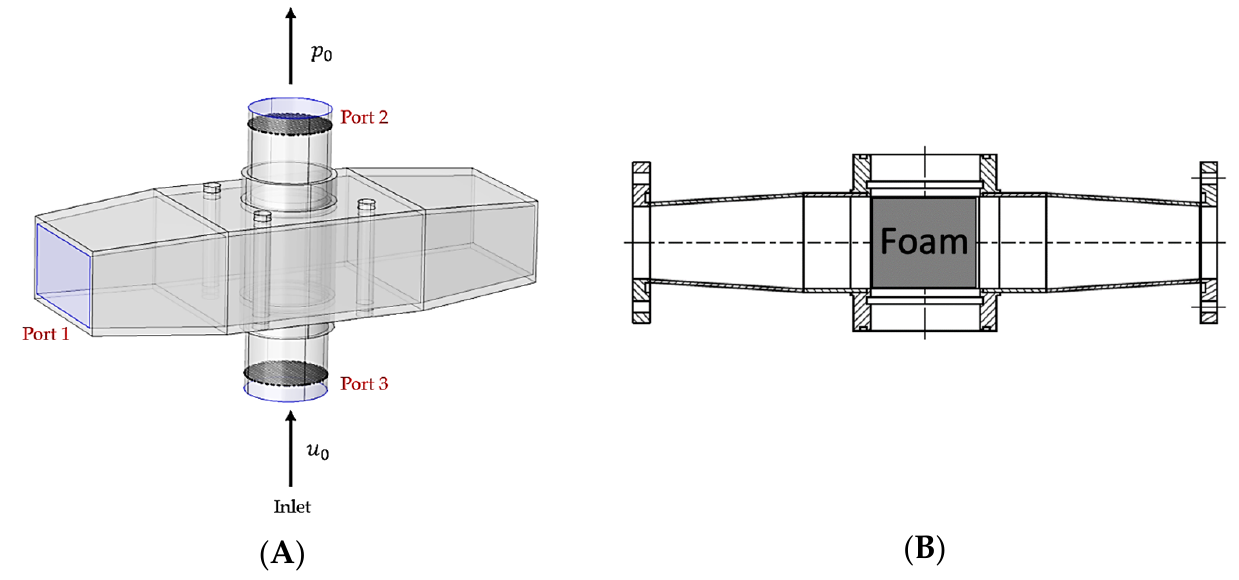
Figure 3. Microwave applicator design: ( A ) model design with boundary surfaces, ( B ) internal view plane displaying the foam position.